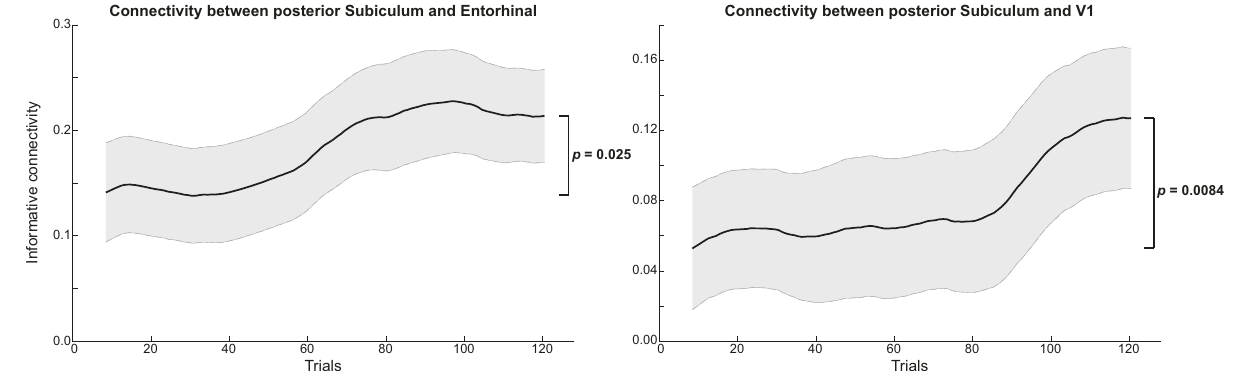
Fig. 6 Experiment 2 informational connectivity between posterior subiculum and neocortex over trials. Time-resolved Pearson correlation between shape evidence in the posterior subiculum and entorhinal cortex (left panel) and V1 (right panel). Time courses were temporally smoothed using a sliding window approach (see Methods for details). N = 24 participants, shaded regions indicate SEM. P values re fl ect two-sided one-sample t -tests (df = 23) against